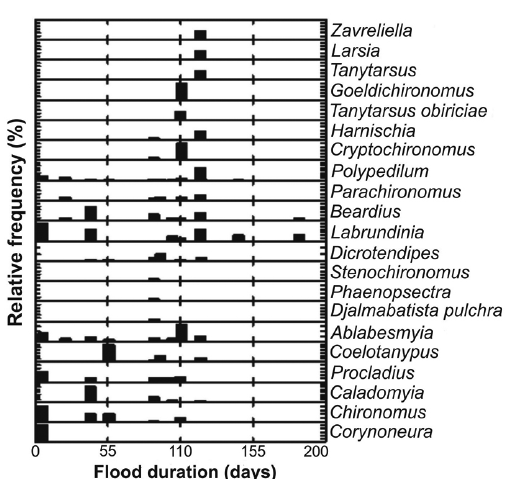
Figure 2. Relative frequency of Chironomidae genera along the gradient in flood duration in a seasonally flooded area of the northern Pantanal,